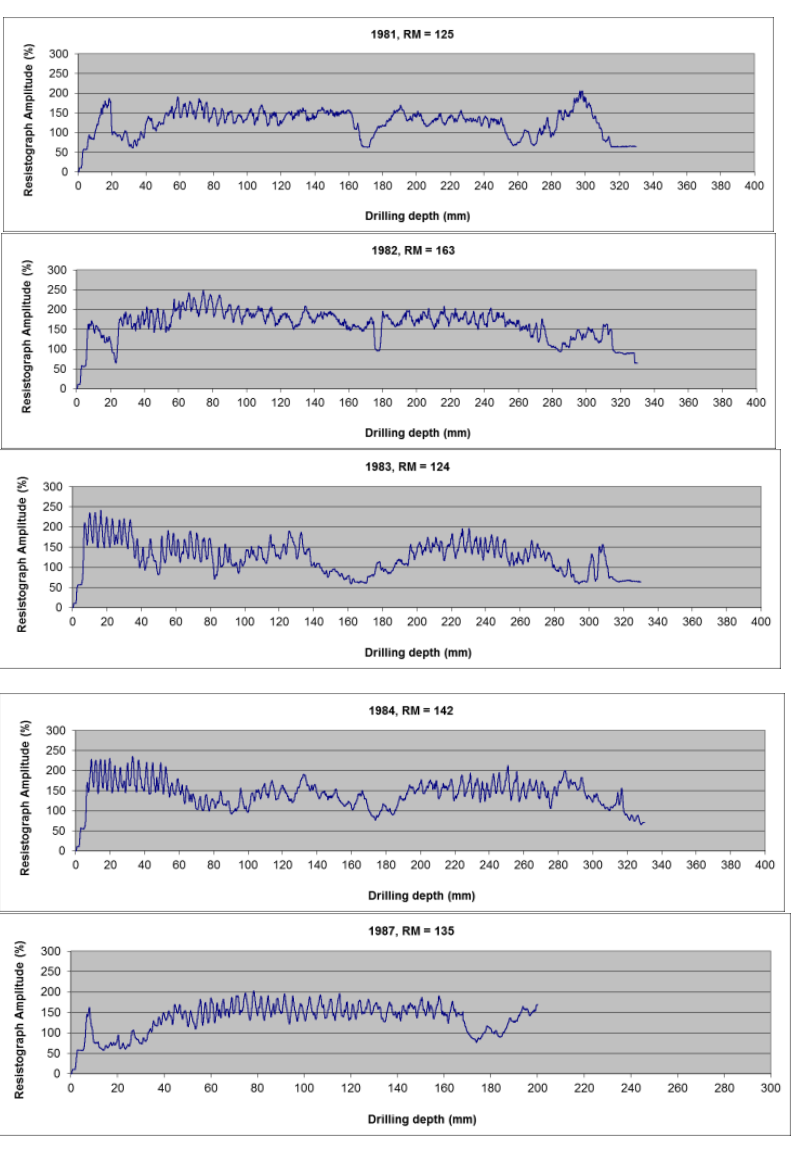
Figure 3. Graphic records from the individual points of measurement by Resistograph, beam (III), measured parallel to the orientation of the pin at the bottom of the beam.